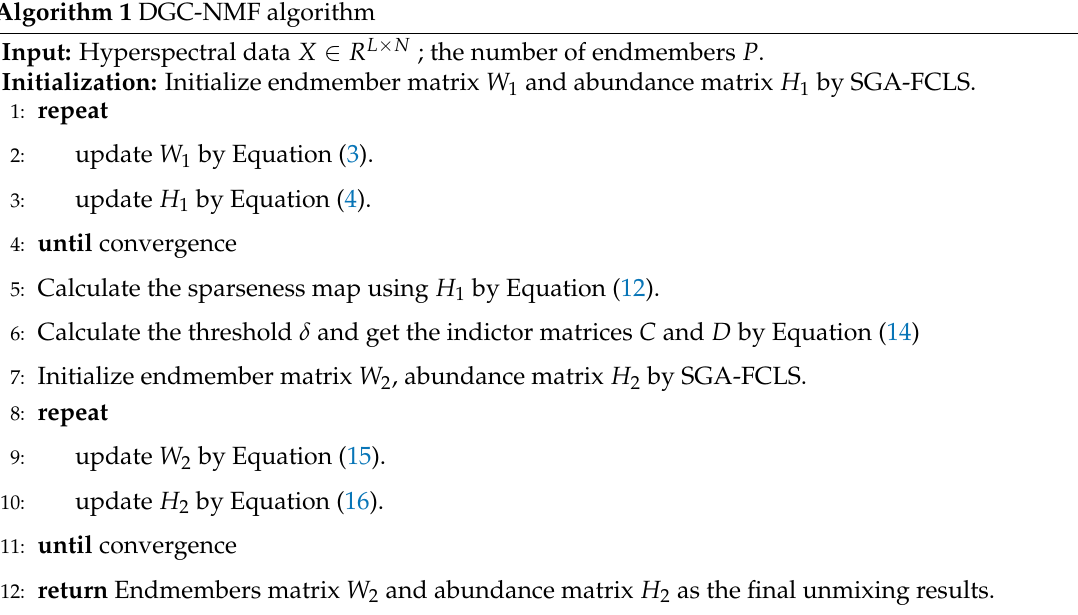
Algorithm 1 DGC-NMF